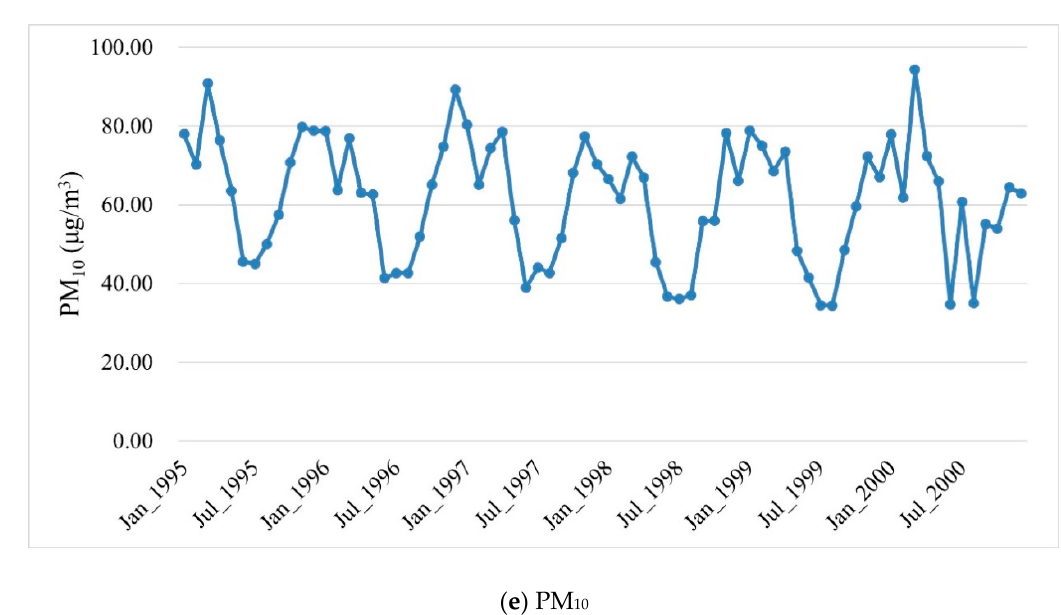
Figure 3. The monthly averages of air pollutant levels over the years of birth of the study cohort.